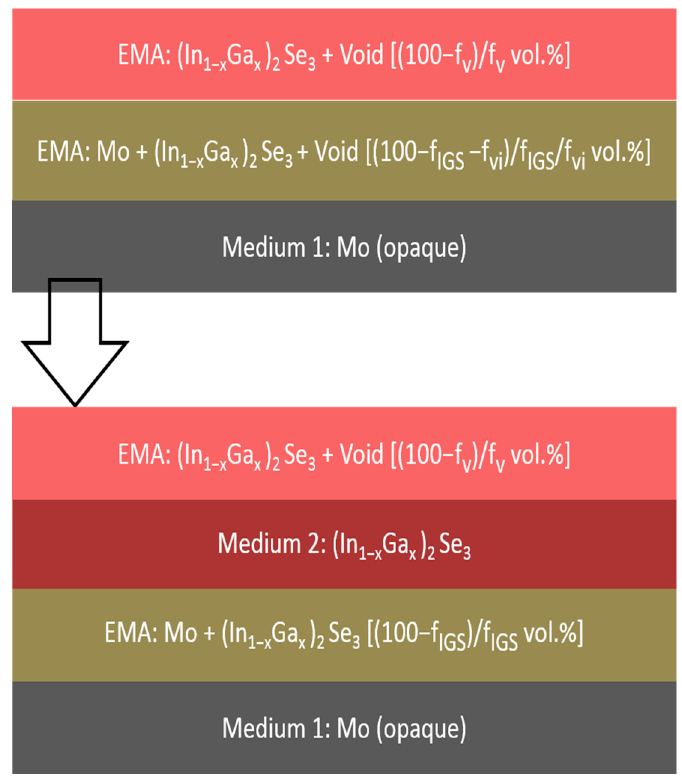
Figure 11. Structural models applied in two time regimes for analysis of RTSE data collected in the initial stage of IGS film growth on a rough Mo surface. In the first regime (top), the voids in the Mo surface roughness layer are filled by IGS as substrate-induced surface roughness associated with the IGS film develops. In this regime, no IGS bulk layer is observed and as a result, the regime is characterized by a two-layer model. The first regime transitions into the second regime (bottom) once the Mo surface roughness layer has been completely converted to a Mo/IGS interface roughness layer. In this second regime, the IGS bulk layer develops and increases in thickness with an IGS surface roughness layer on top, resulting in a three-layer model.